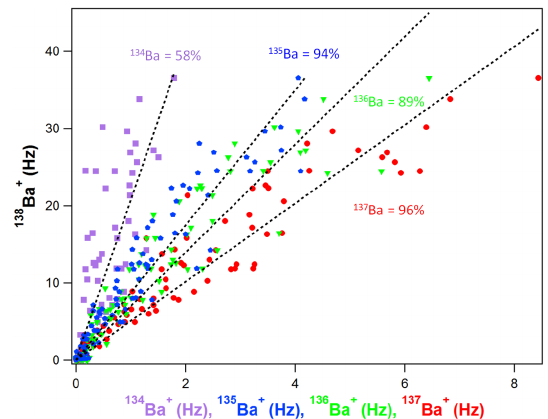
Figure 1. Barium isotopic pattern measured in the laboratory. The percentages correspond to the isotopic compositions relative to the most abundant ( 138 Ba + )